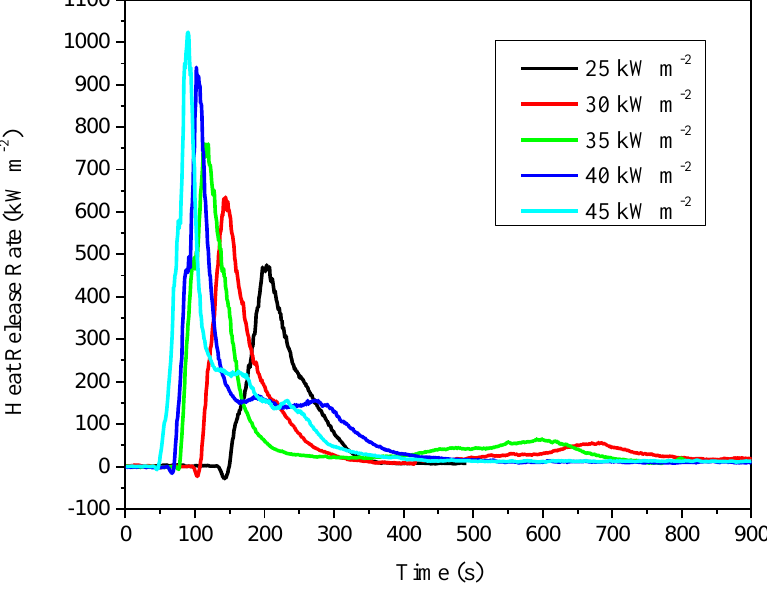
Figure 8. Heat release rate (KW m −2 ) versus time (s).